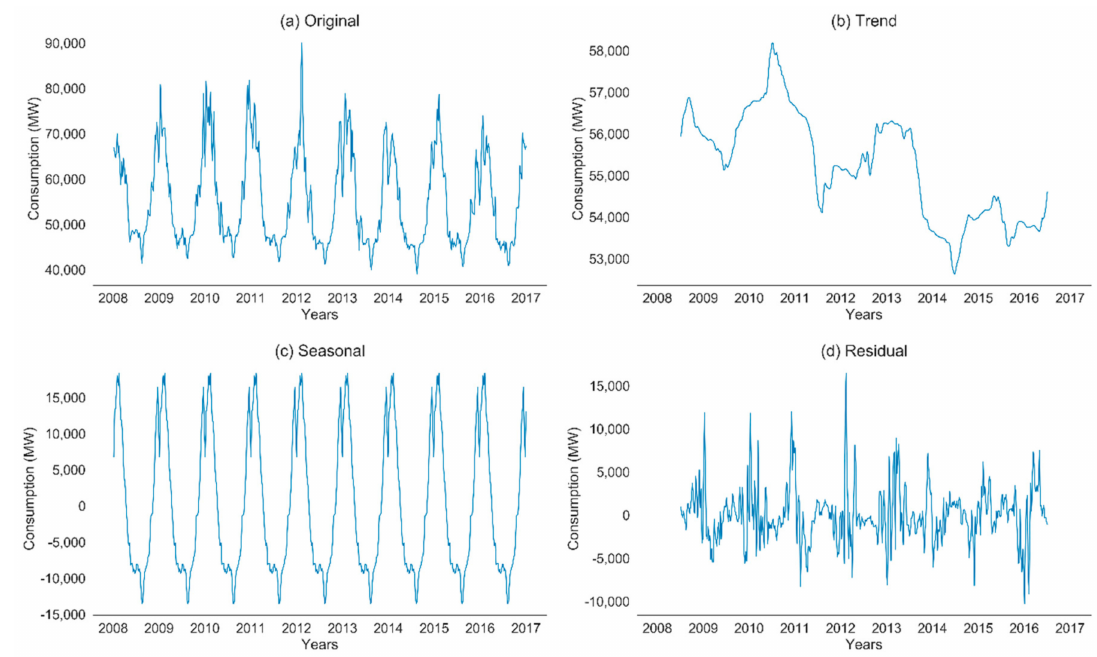
Figure 7. Original and decomposed time series.